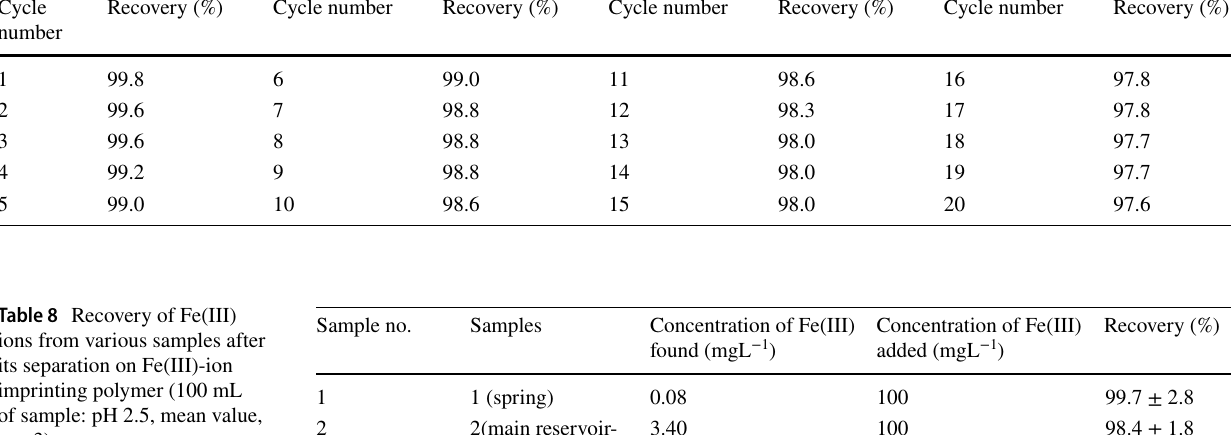
Table 7 Effect of reused times on the recovery of the Fe(III)-IIP (10 mL of sample: pH 2.5, mean value, n = 3) Cycle number